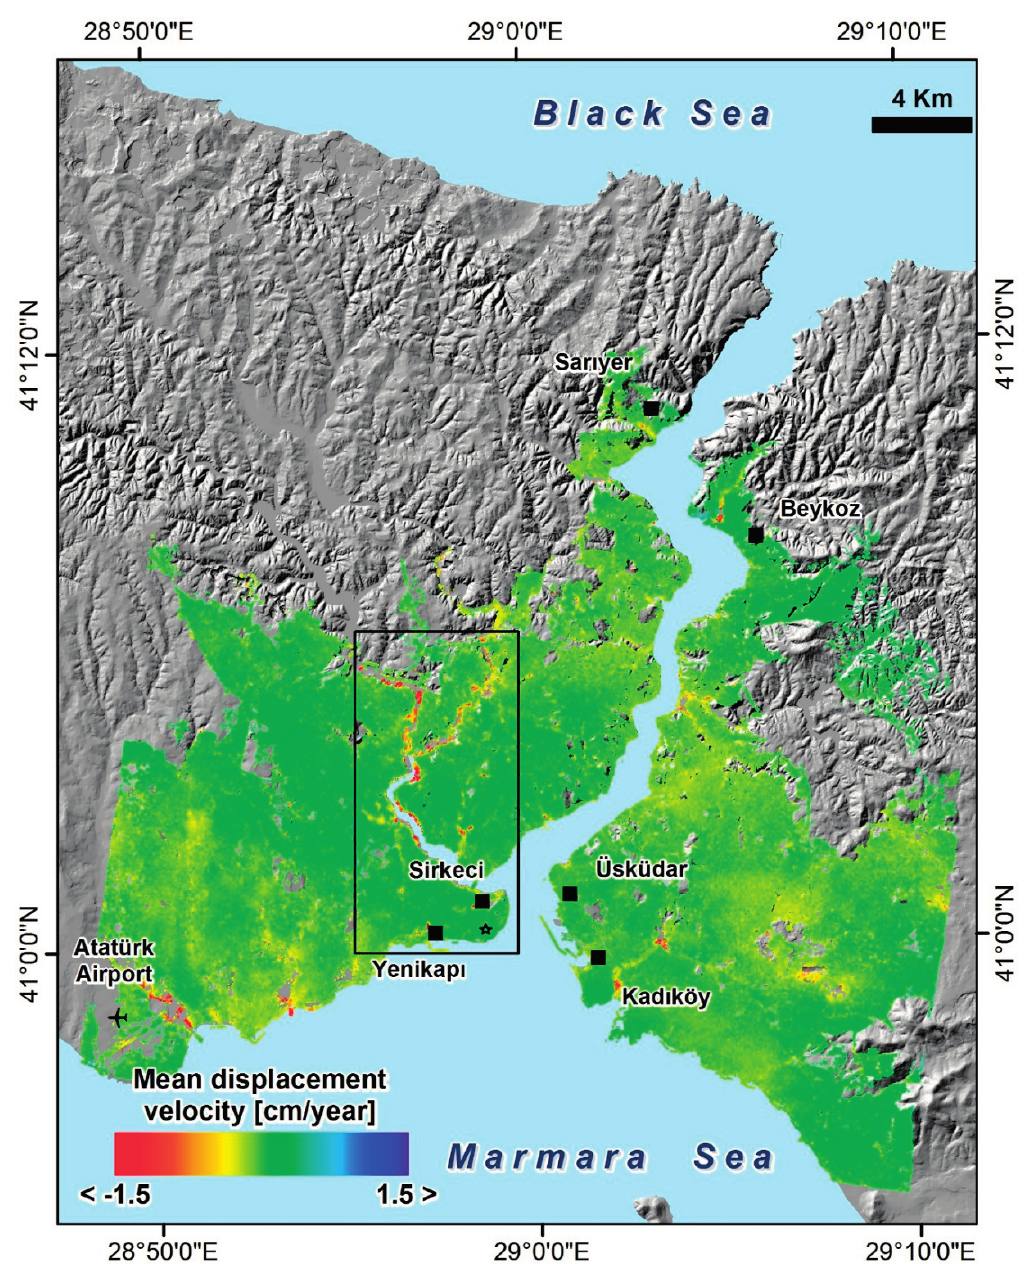
Figure 4. Low resolution deformation velocity map of Istanbul urban area, superimposed on hill shade image derived from DEM. The SBAS-DInSAR map has been obtained by processing TerraSAR-X images acquired in the 2010–2012 time interval. Note that a temporal coherence threshold of 0.8 has been used. Black star shows location of the stable point selected as reference for DInSAR measurements. Black polygon shows location of the study area (see Figure